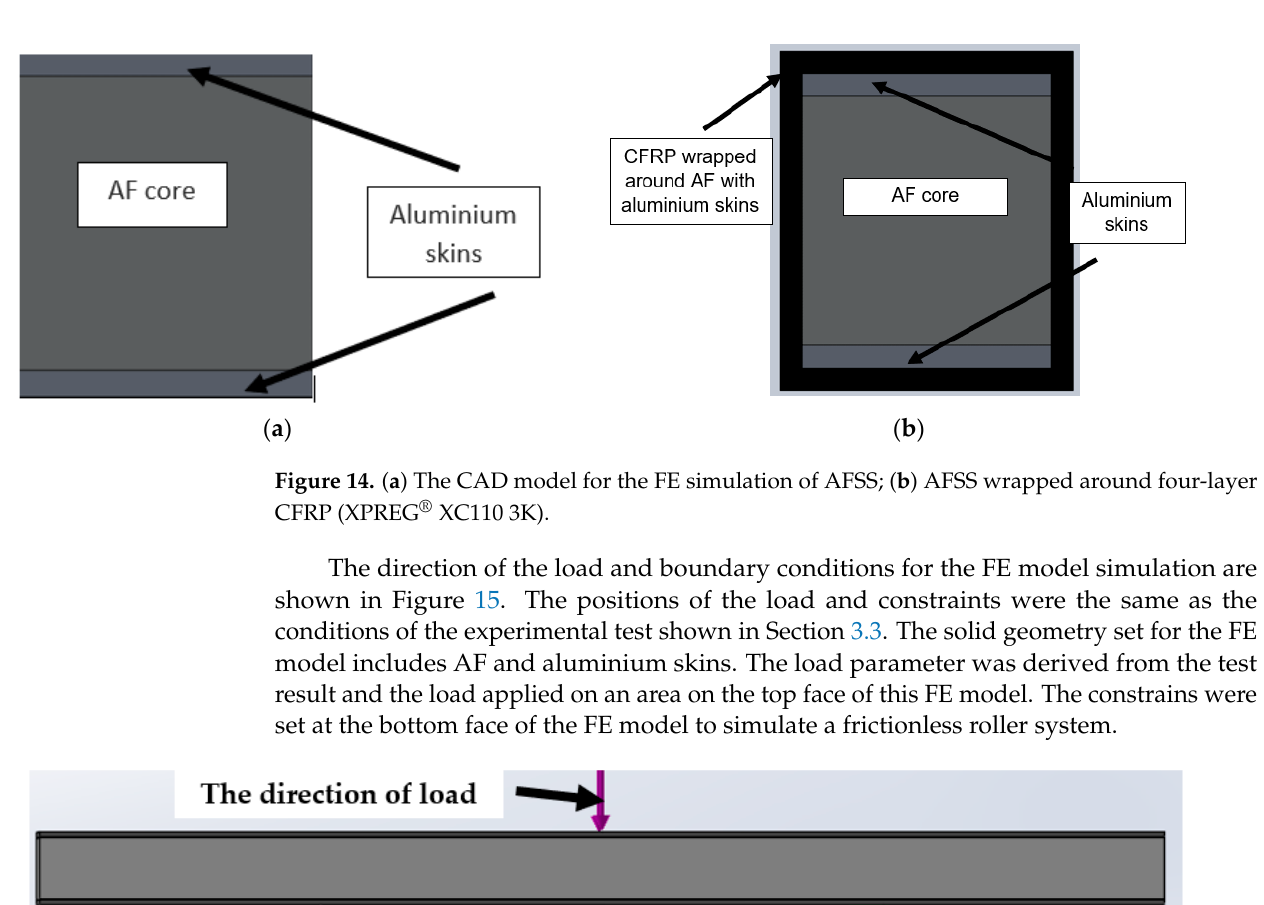
Figure 15. Schematic of boundary conditions and load direction.